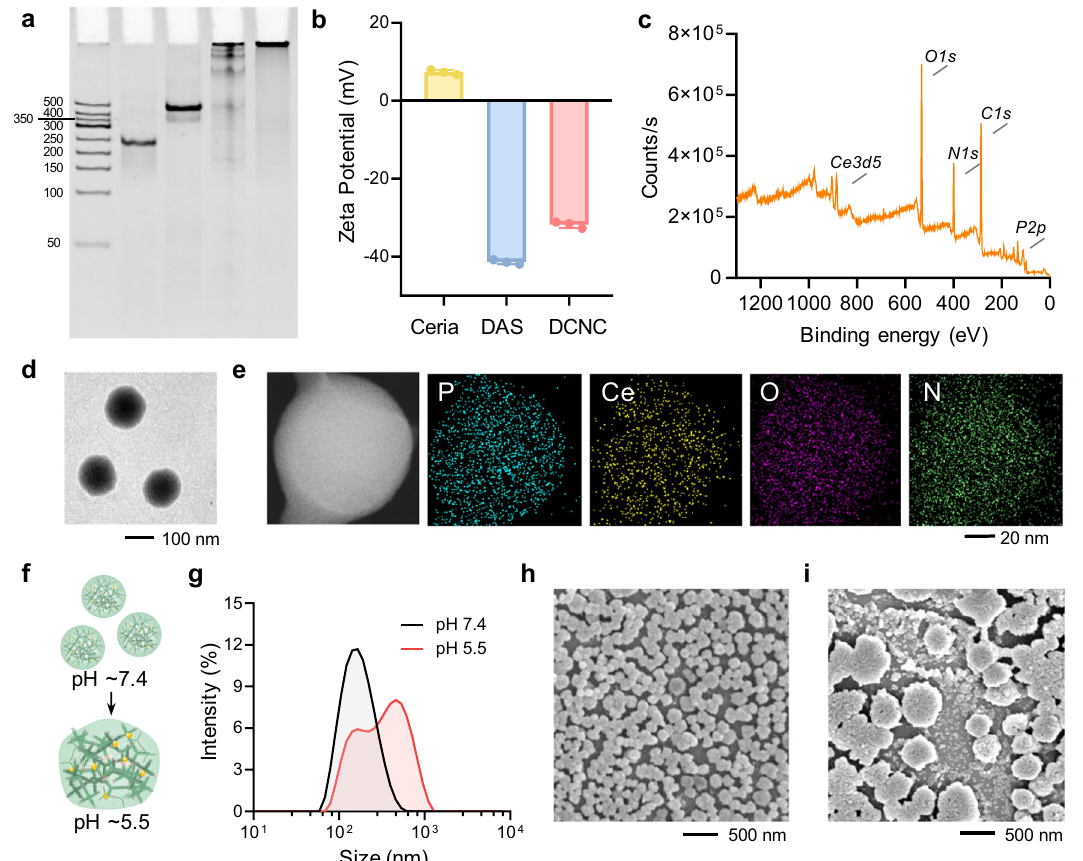
Fig. 2 | The synthesis and characterization of DCNC. a 12% polyacrylamide gel electrophoresis (PAGE) for verifying the synthesis of Y-DNA, X-DNA, DAS, and DCNC. b Zeta potential measurement of ceria, DAS, and DCNC. Bars represent mean±SD( n =3 independent samples). c X-ray photoelectron spectroscopy (XPS) analysis of DCNC. d Representative transmission electron microscopy (TEM)